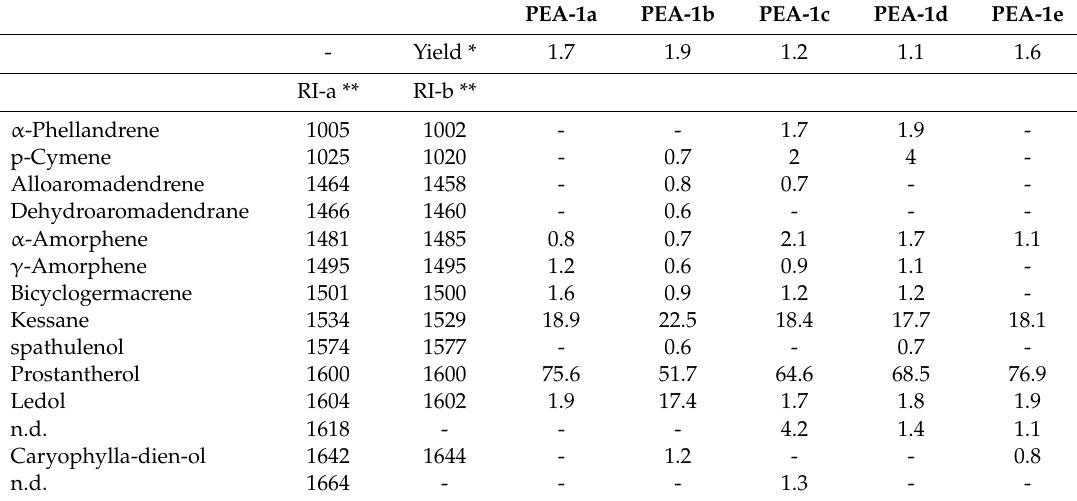
Table 5. Essential oils from P. petraea